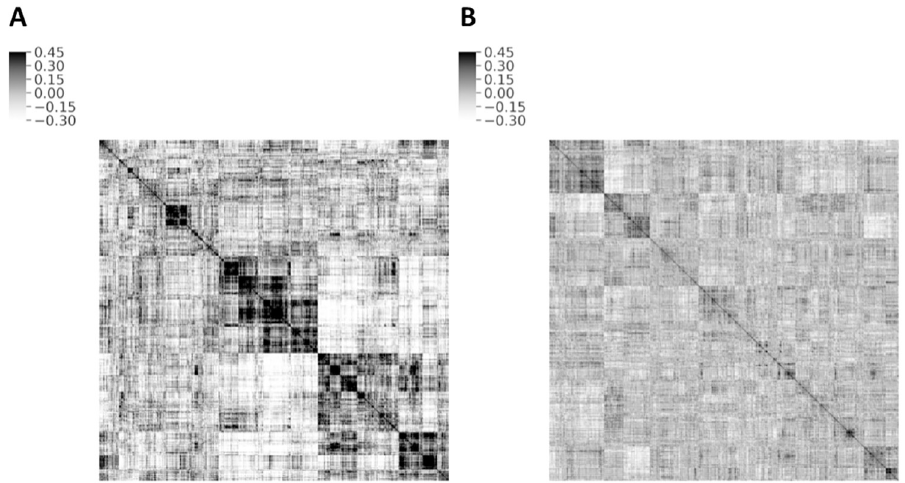
Fig 3. The cluster map of two essential and nonessential gene networks. A: Cluster map of essential gene network, B: Cluster map of nonessential gene network.